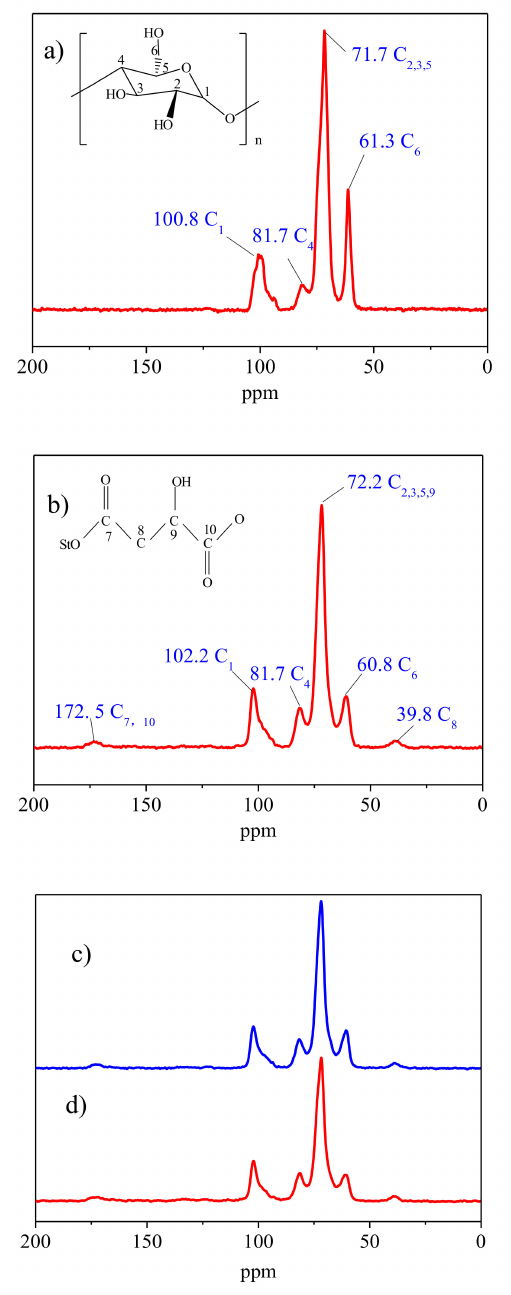
Figure 4. 13 C CP/MAS NMR spectra of malate starch samples: ( a ) native pea starch, ( b ) malate starch, ( c ) HMT-malate starch, and ( d ) malate-HMT